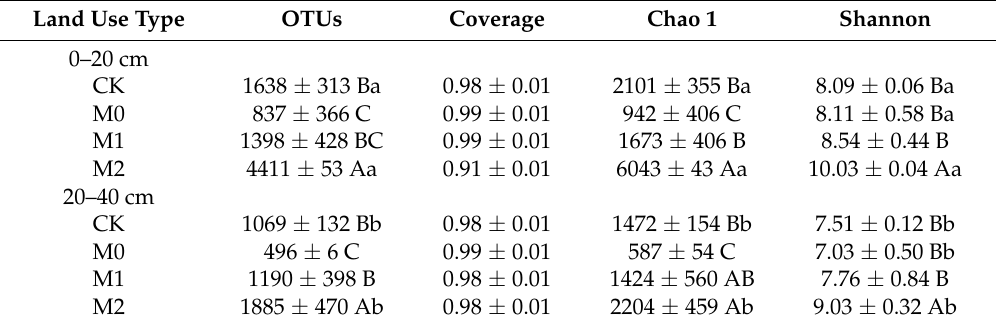
Table 4. Sequence statistics and diversity indexes of soil bacteria under different land use types (mean ± S.E., n = 3).